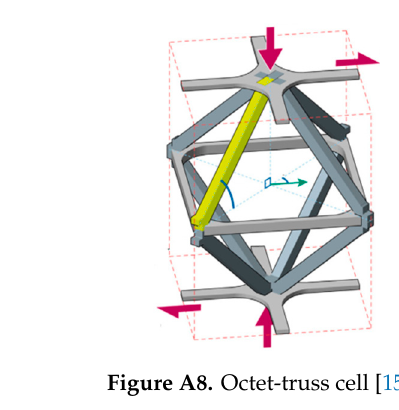
Figure A7. ( a ) Cubic.; ( b ) G7; ( c ) Rhombic dodecahedron [150].